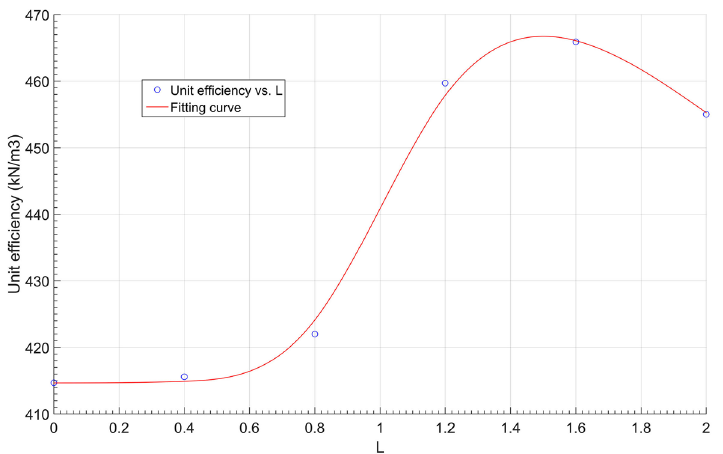
Figure 16. Anchorage efficiency vs. bell spacing curve of group